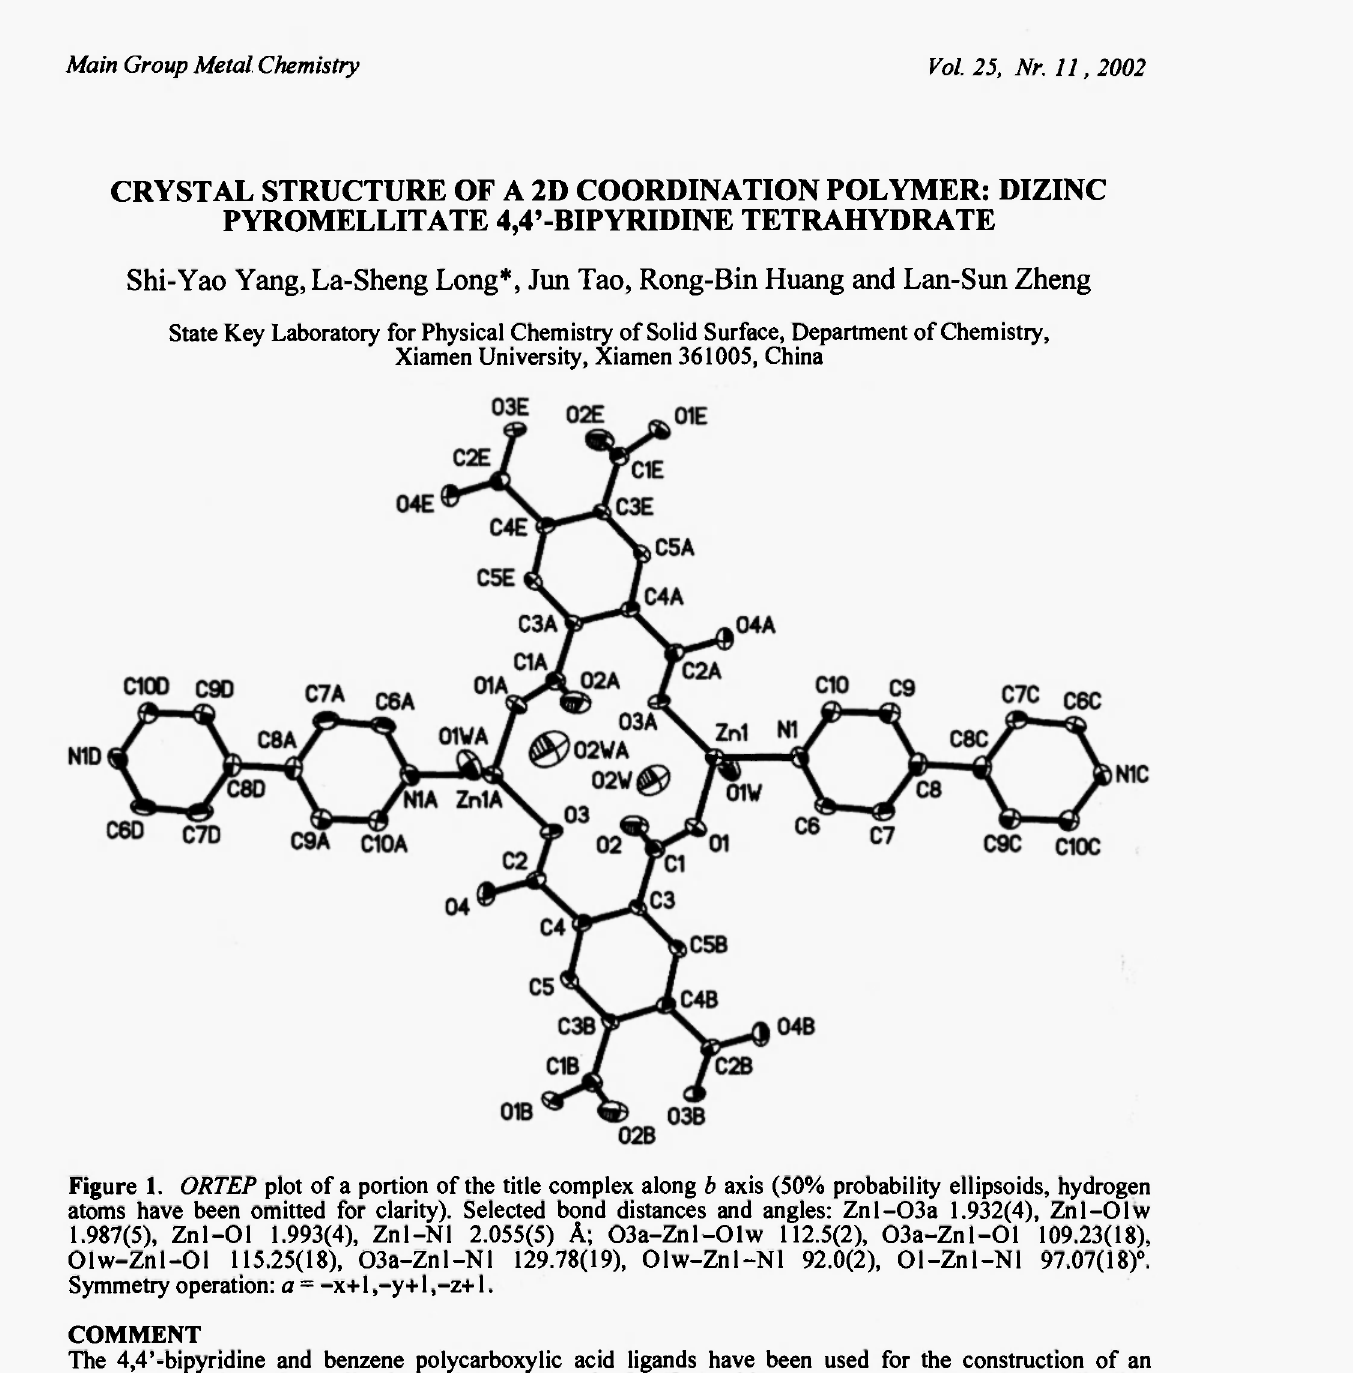
Figure 1. ORTEP plot of a portion of the title complex along b axis (50% probability ellipsoids, hydrogen atoms have been omitted for clarity). Selected bond distances and angles: Znl-03a 1.932(4), Znl-Olw 1.987(5), Znl-Ol 1.993(4), Znl-Nl 2.055(5) Ä; 03a-Znl-01w 112.5(2), 03a-Znl-01 109.23(18), Olw-Znl-Ol 115.25(18), 03a-Znl-Nl 129.78(19), Olw-Znl-Nl 92.0(2), Ol-Znl-Nl 97.07(18)°. Symmetry operation: a =